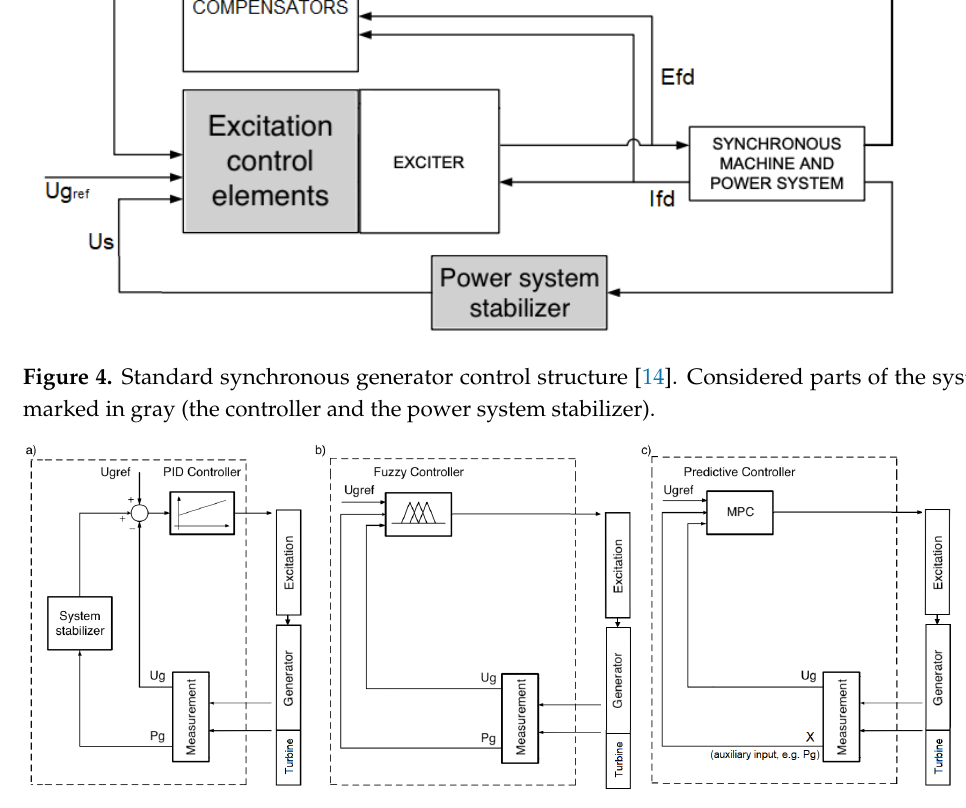
Figure 5. Generator’s control structures: ( a ) classic structure, ( b ) fuzzy logic controller, ( c ) model predictive